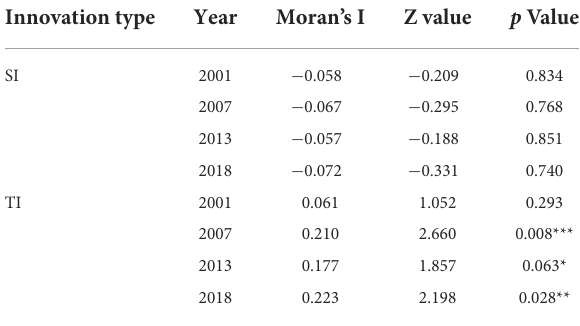
TABLE 2 Moran’s I of SI and TI